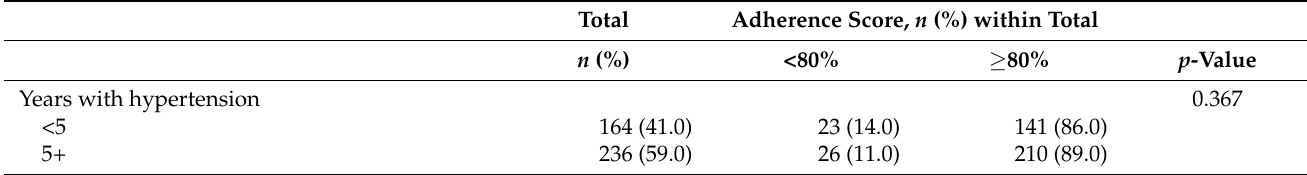
Table 3. Bivariate analysis of experiences with hypertension and